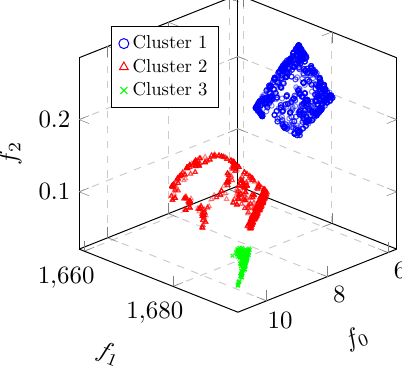
Figure 2. Non-dominated solutions from RE3-5-4 using offline KDO.